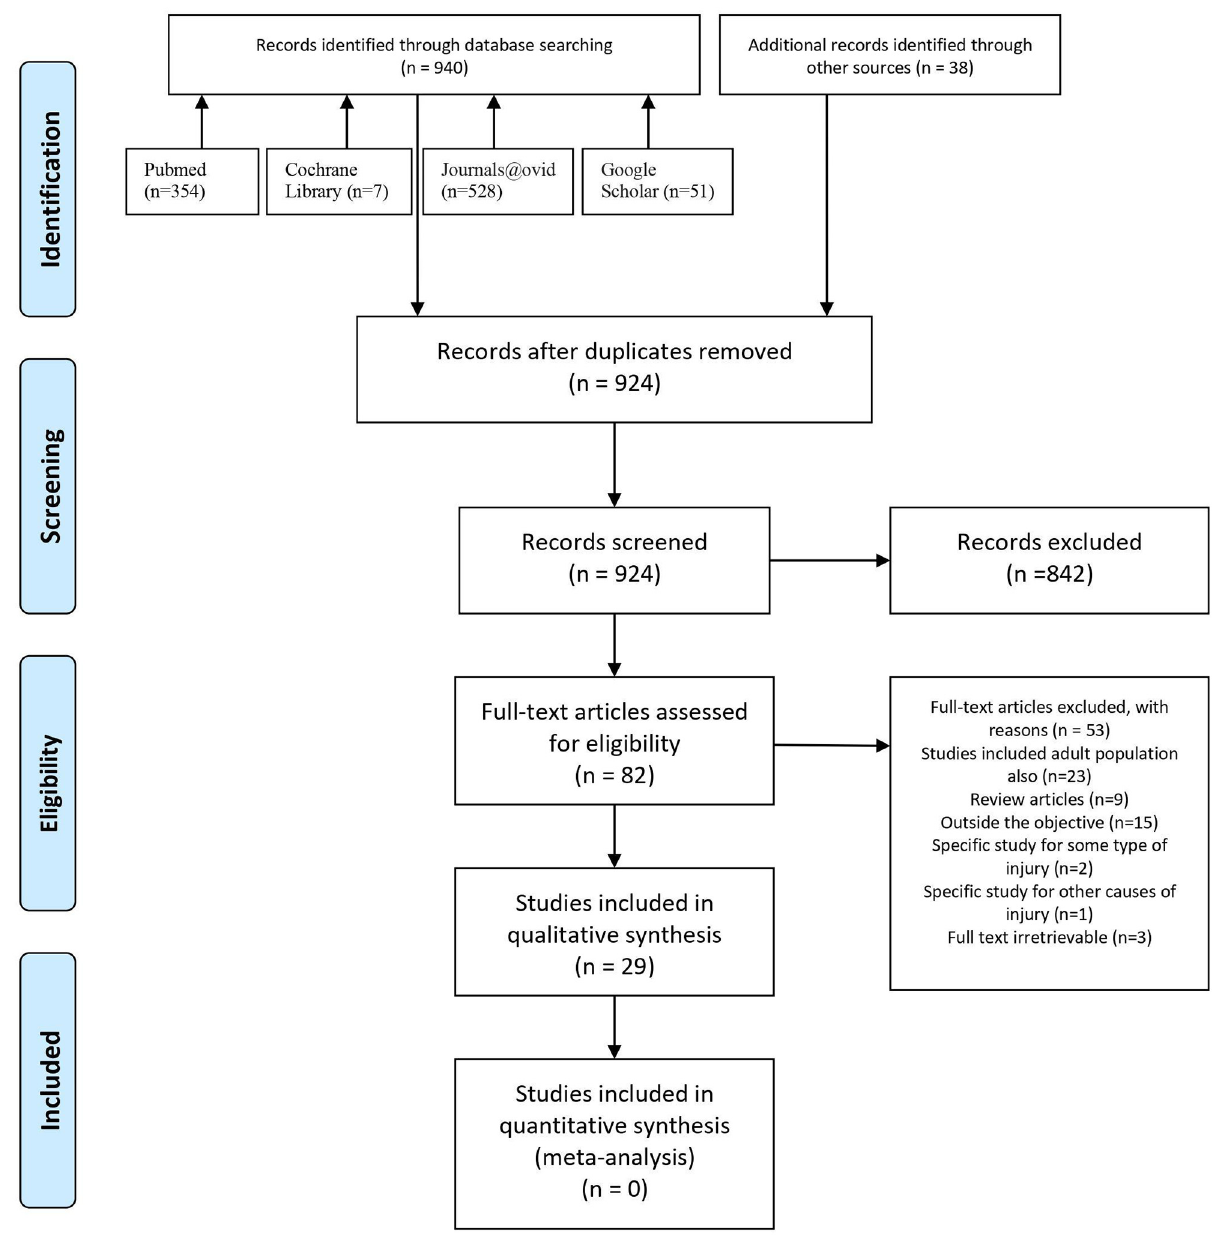
Fig. 1. PRISMA fl